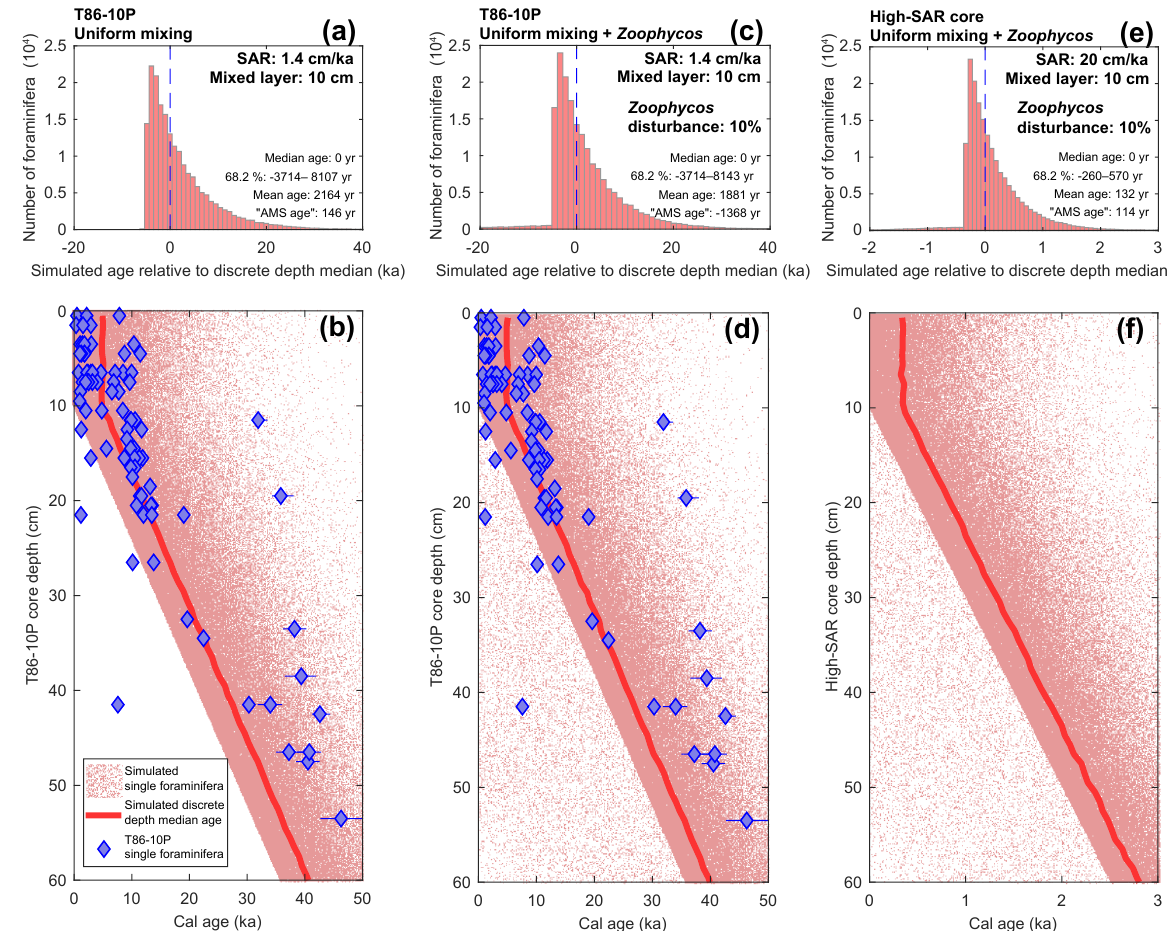
Figure 3. In order to investigate the age distribution for discrete depths of a sediment core, we carried out simulations of multiple single- foraminifera sedimentation scenarios. Each of the simulations assumes a constant SAR, with foraminifera of the same size and species. Each scenario begins at 150cm core depth and continues in 0.1cm intervals to 0cm depth. At each 0.1cm interval, 400 new synthetic foraminifera are created and assigned an age according to the SAR. At every 0.1cm interval, the uppermost 10cm (the assumed mixed-layer depth) of synthetic sediment core is uniformly mixed using random noise. While the simulations start at 150cm, we only show data to 60cm depth, in order to rule out any artefacts due to simulation spin-up. (a, b) Single-foraminifera simulation using an assigned SAR of 1.4cmka − 1 and mixed-layer depth of 10cm. The scatter plot in (b) shows all simulated single foraminifera, along with the simulated discrete depth (1cm depth slice) median age. Superimposed are the calibrated ages of the actual single foraminifera that we analysed in T86-10P. The histogram in (a) represents the age value of all simulated single foraminifera between 0 and 50cm relative to their associated discrete 1cm depth interval median age. The 68.2% percentile range, mean, median and AMS age are calculated for the histogram. AMS age is calculated by converting every single-foraminifera age value to F 14 C, from which a mean F 14 C value is calculated and subsequently converted back to 14 Cyr. For these first-order AMS age estimations, we assume that 14 C years are equal to calendar years (i.e. constant past (cid:49) 14 C). (c, d) As for (a, b) (SAR 1.4cmka − 1 and mixed-layer depth of 10%) but with added simulation of Zoophycos burrows. Zoophycos is added post-simulation by taking 10% of all foraminifera from all depths and increasing their depth value with a random value between 0 and 50cm. (e, f) High-SAR single-foraminifera sedimentation simulation (20cmka − 1 and 10cm mixed-layer depth) with Zoophycos added in the same manner as for (c, d)